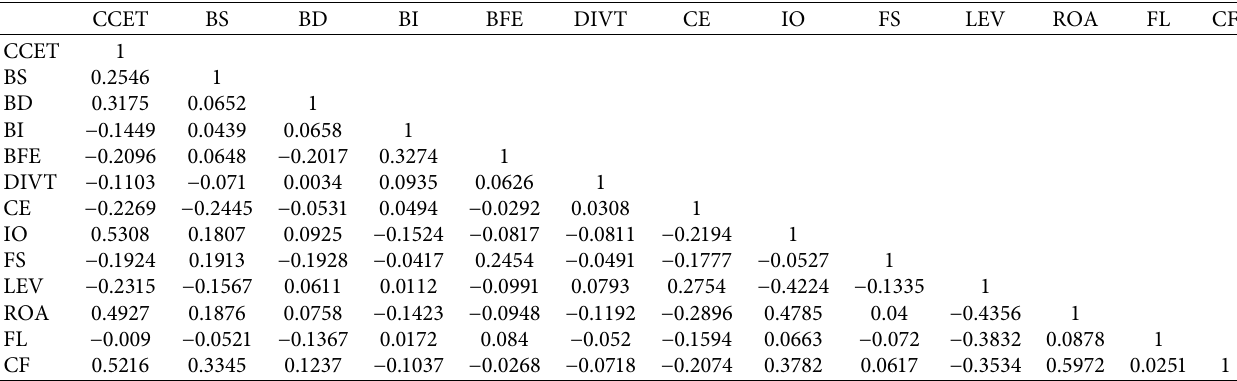
Table 3: Correlation